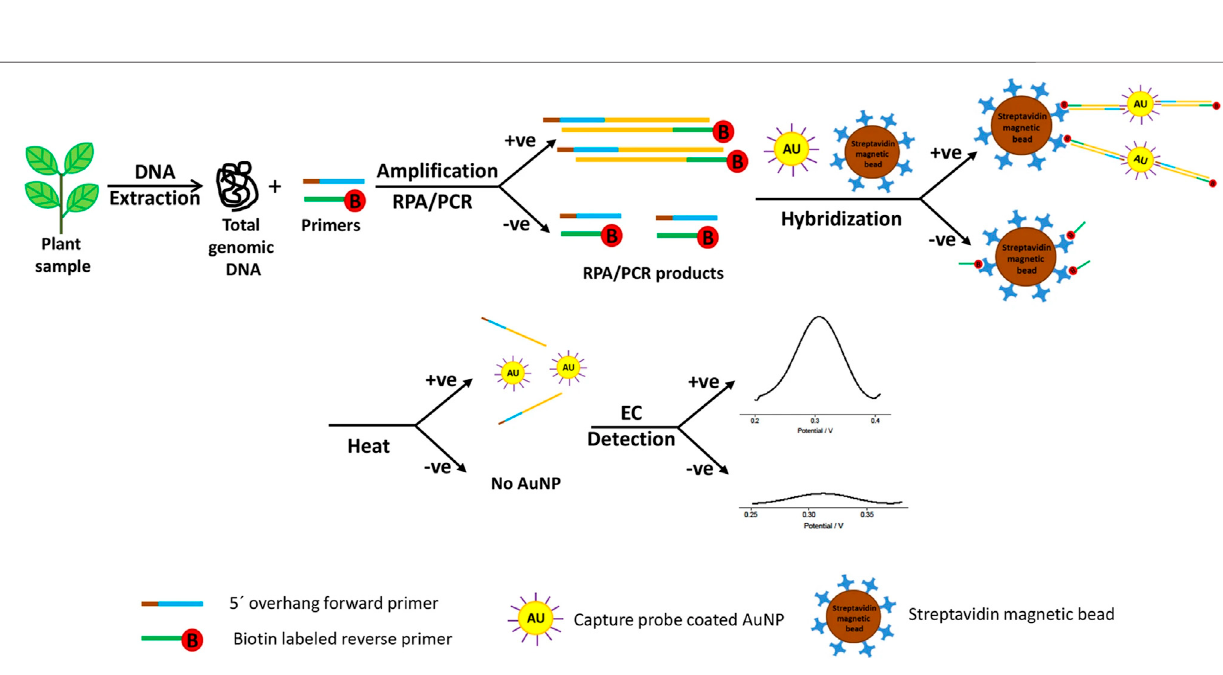
Frontiers in Chemistry |